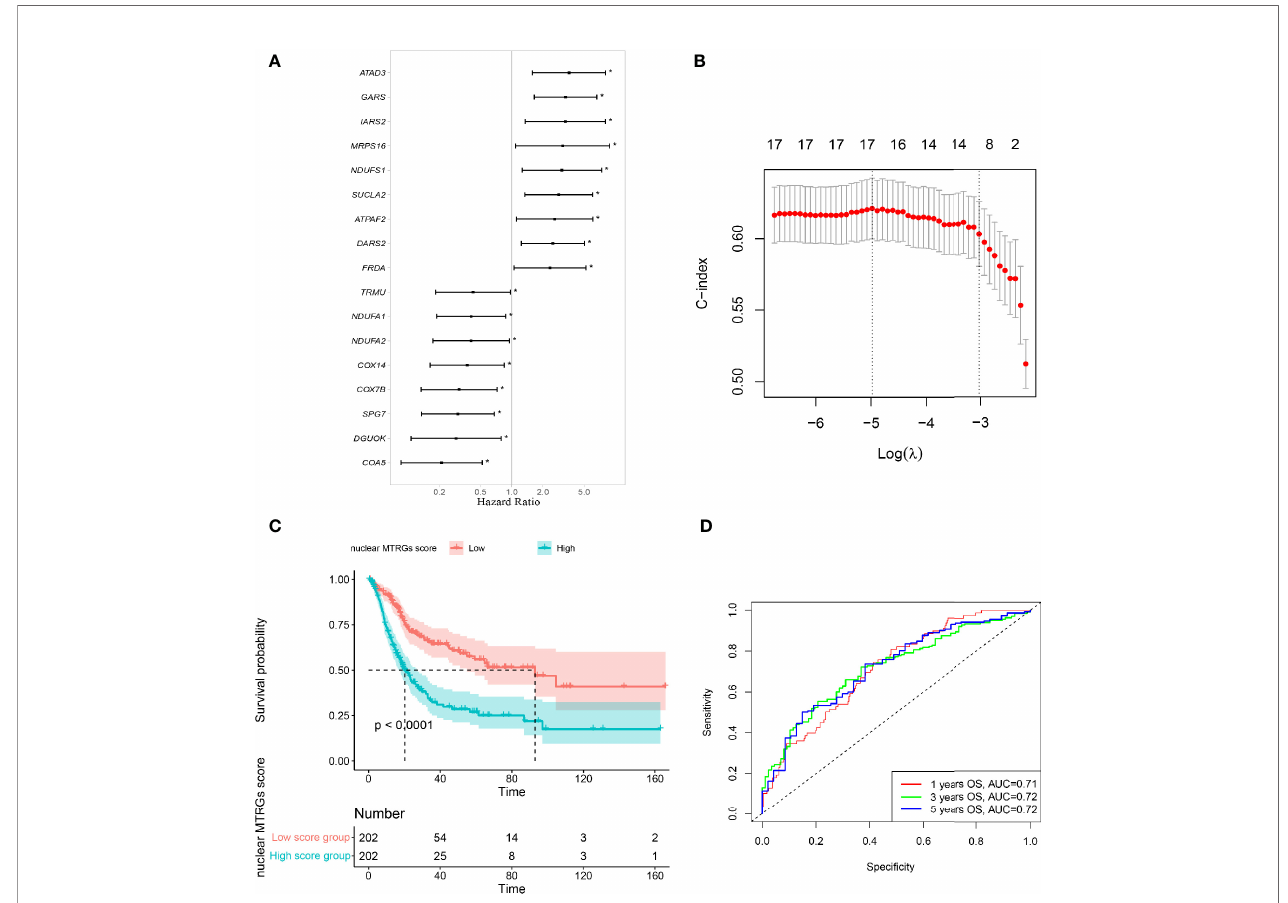
FIGURE 2 | Construction of a nuclear MTRGs signature. (A) The identi fi cation of the nuclear mitochondria-related genes associated with survival of BC patients via univariate Cox regression analysis. (B) The LASSO analysis determined a nuclear 16-MTRGs signature. (C) Comparison of OS between the high and low nuclear MTRGs score groups via Kaplan-Meier curves. (D) The ROC curves for OS at 1, 3, and 5 years. *p < 0.05.